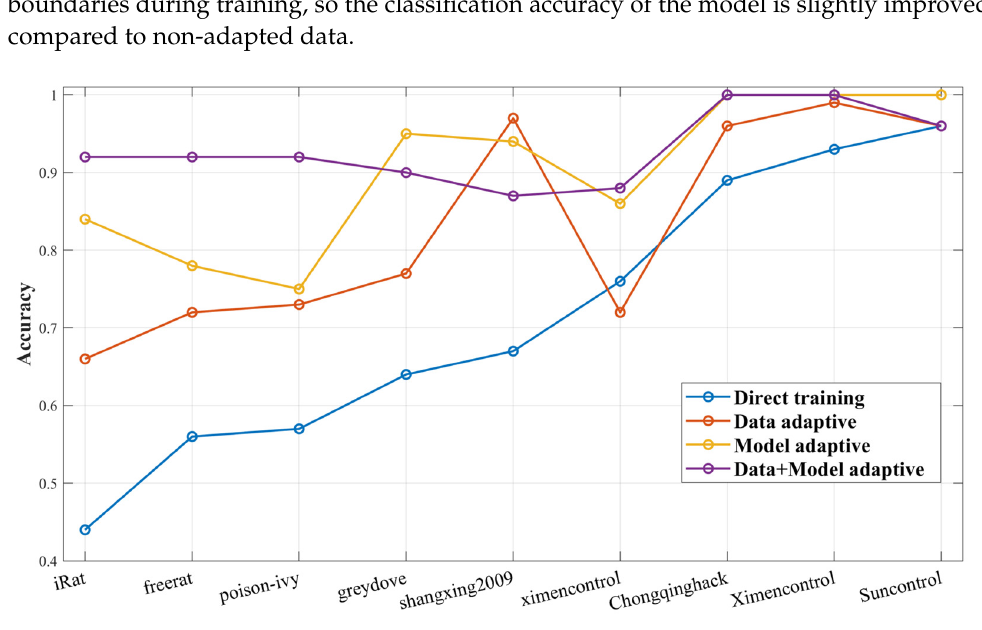
Figure 8. Classification accuracy of ablation experiments on nine data